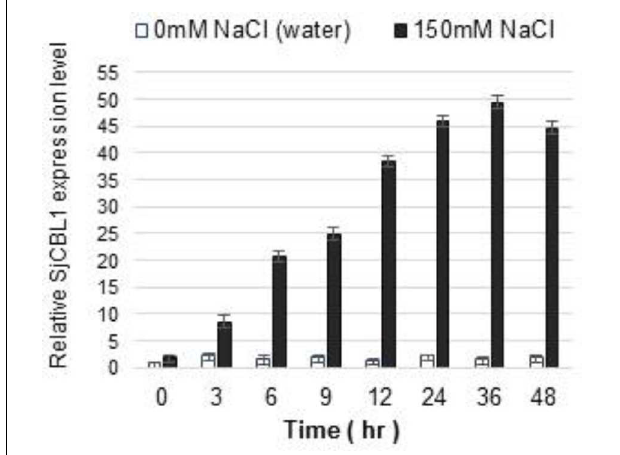
FIGURE 9 | Induction of SjCBL1 expression levels by high salt treatment in Sedirea japonica . Quantitative RT-PCR analysis was used to determine the SjCBL1 transcript levels in the orchid plants. Total RNAs were isolated at the indicated time points from the leaves of 7-month-old orchid plants treated with NaCl (150 mM) or water (as a control). An actin gene identified in Sedirea japonica, SjActin (GenBank accession number: JN981139.1), was employed as an internal control for transcript normalization. The SjCBL1 expression level at the 0 time point was set to 1.0 to show relative abundance